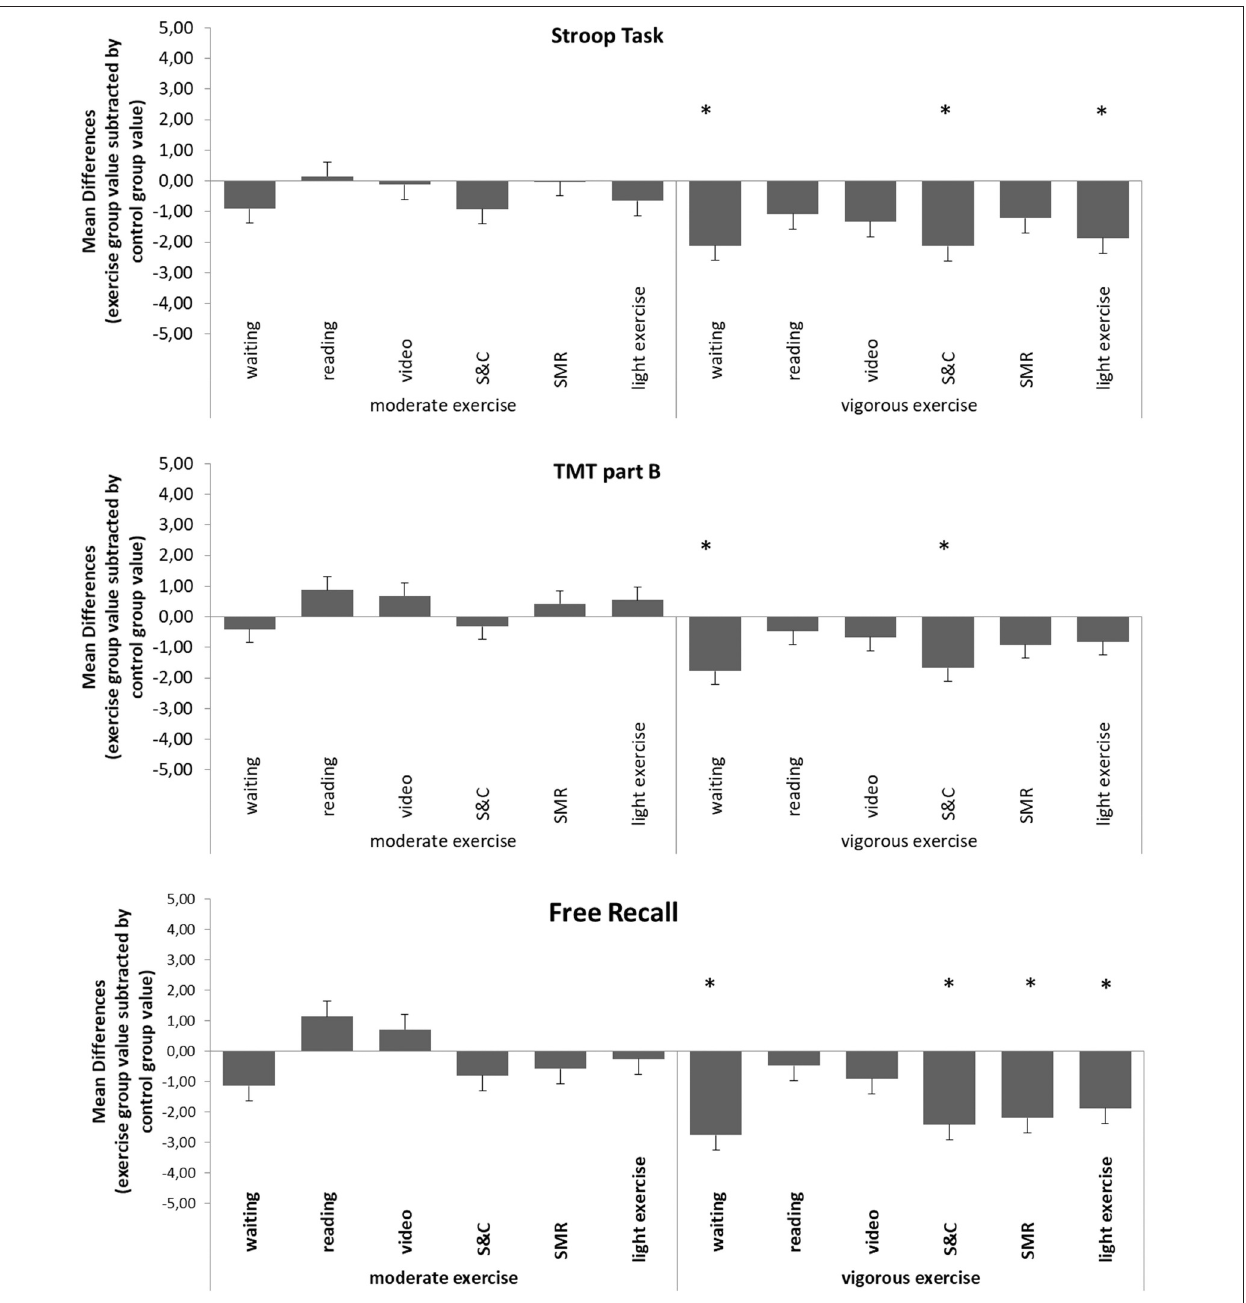
FIGURE 2 | Differences between participants’ mean expectations for cognitive benefits toward acute moderate/vigorous endurance exercise and toward control group treatments Mean expectation toward each control treatment is subtracted from the mean expectation toward acute moderate/vigorous endurance exercise. Positive/negative differences indicate higher/lower expectations for cognitive benefits toward the exercise treatment compared to the specific control group treatment. (S&C, supervised stretching, myofascial release and coordination training session; SMR, supervised myofascial release training session; TMT, Trail Making Test; * p <